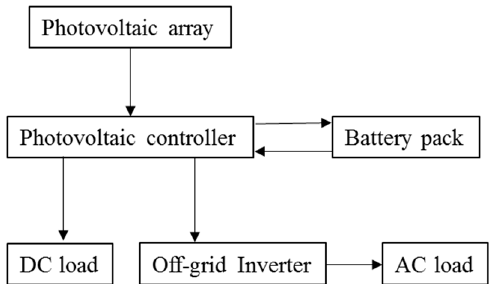
Figure 2. Schematic view of an off-grid system and key components.